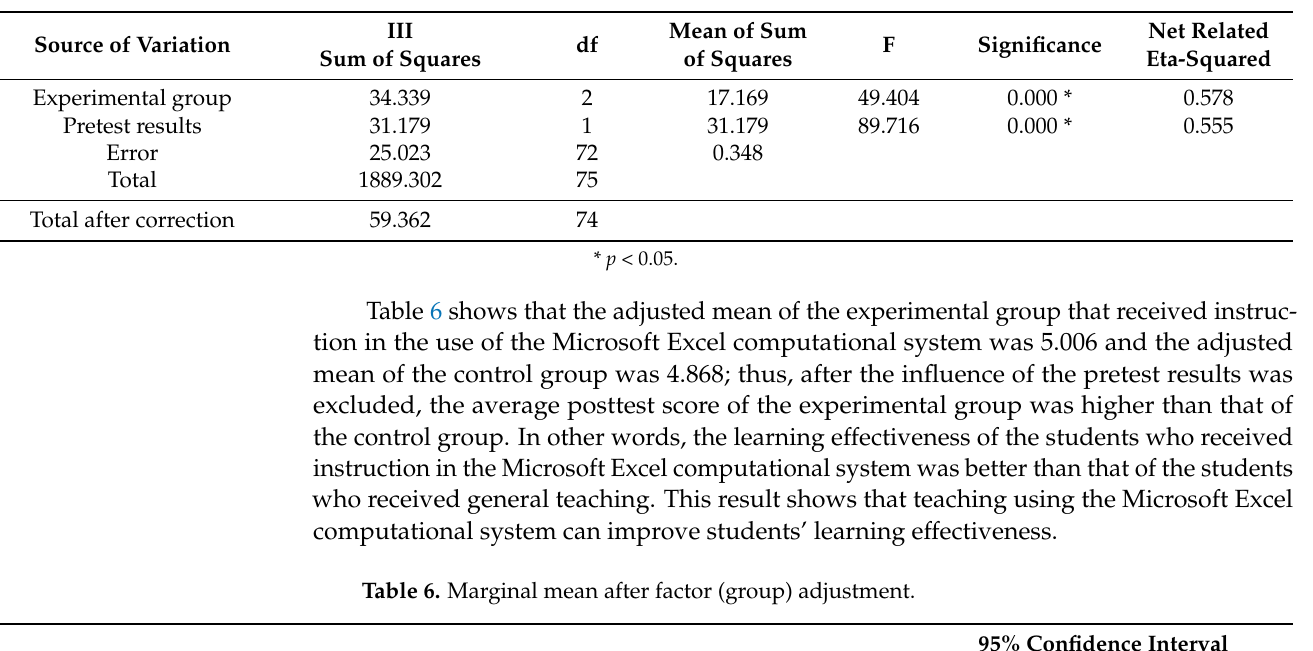
Table 5. Summary of the univariate ANCOVA of the posttest results for the experimental group.